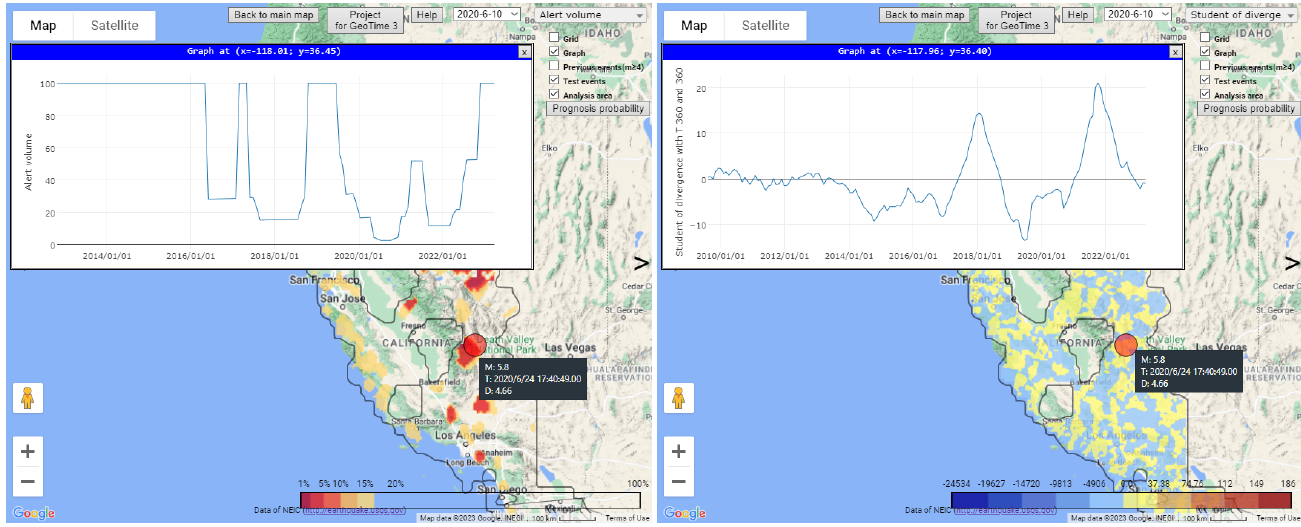
Figure 4. Analysis of earthquake forecast for a 5.8 magnitude earthquake on 24 June 2020. Left : Alarm zone (10 June 2020–10 July 2020) with earthquake epicenter (red circle center) and plot of alarm field values at the epicenter. Right : Map of the field of increasing divergence values of average strain rate for 360 days (16 June 2019–10 June 2020) compared to the average strain rate for the previous 360